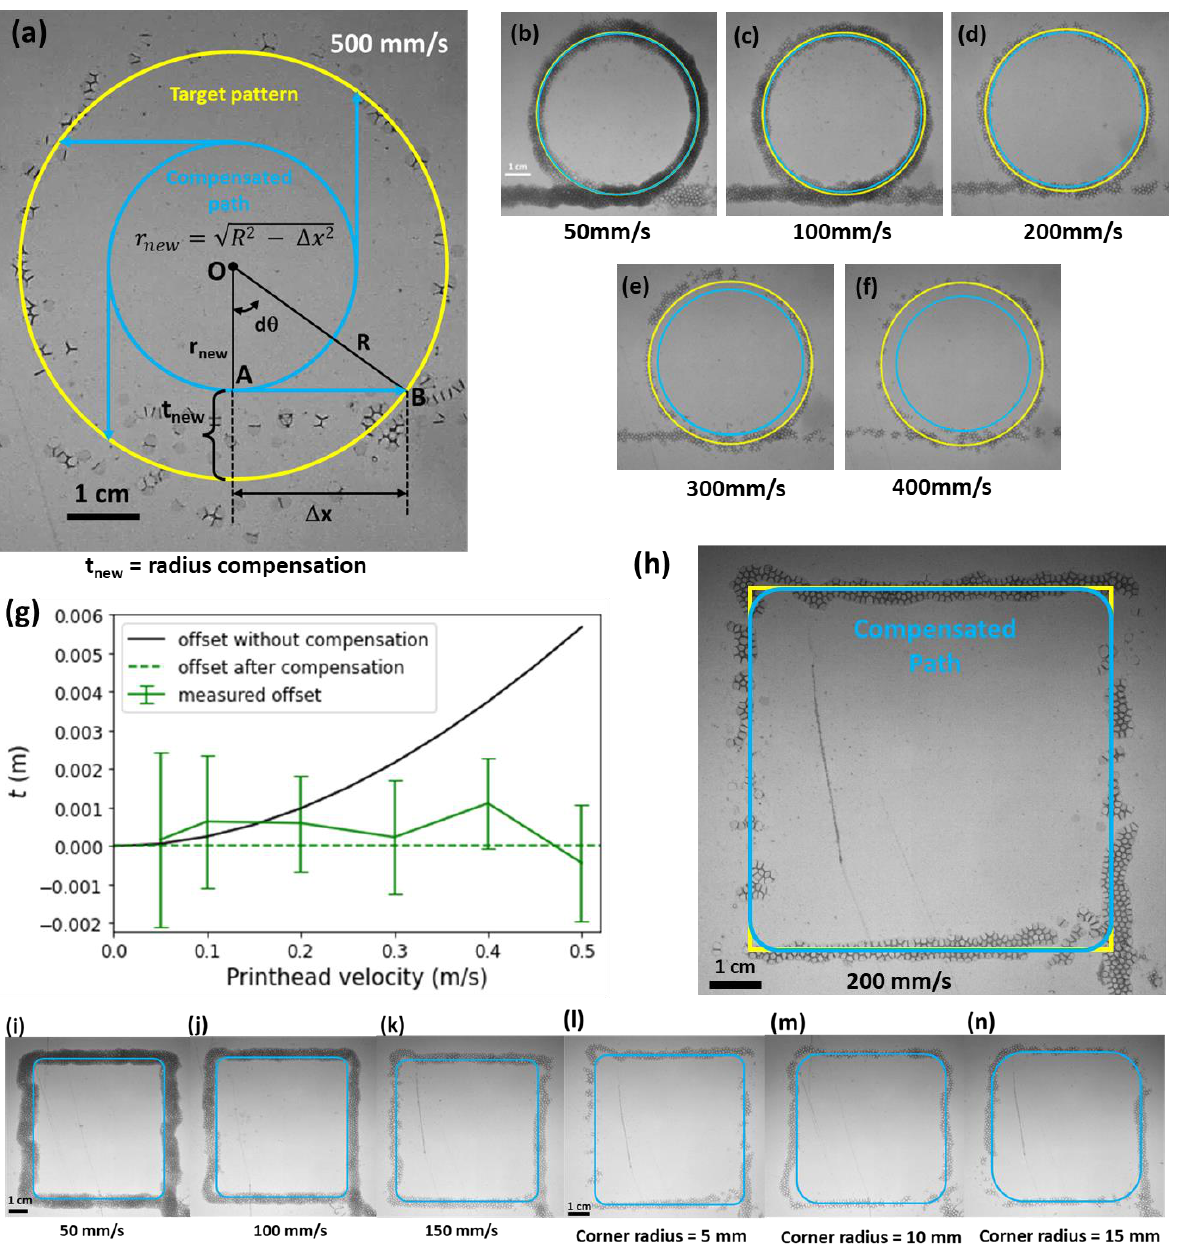
Figure 4. Print path compensation scheme to alleviate the generated offset at different printer velocities. ( a ) Photo of the target circular pattern with a radius R = 30 mm (in yellow), the observed printed foam strands (photo), and the compensated path of the printhead to obtain this target. The printhead velocity was set to v p = 500 mm/s. ( b – f ) Printed patterns (photos) match the target diameter (yellow line) by adjusting the printhead trajectory to a calculated path (blue line) for velocities as indicated. ( g ) Measured offset (markers) compared to the target (red dashed line). The black line shows the modeled offset without compensation. ( h ) Photo of a foam strand in a compensated pattern with corner radius of 5 mm, for a printhead velocity, v p = 200 mm/s. ( i – k ) Printed rounded squares for velocities from 50 mm/s to 200 mm/s (in ( h )). ( l – n ) Printed patterns for increasing corner radii. The control parameters of these prints were Q = 15 mL/min, P = 7 kPa, and a = 1 m/s 2